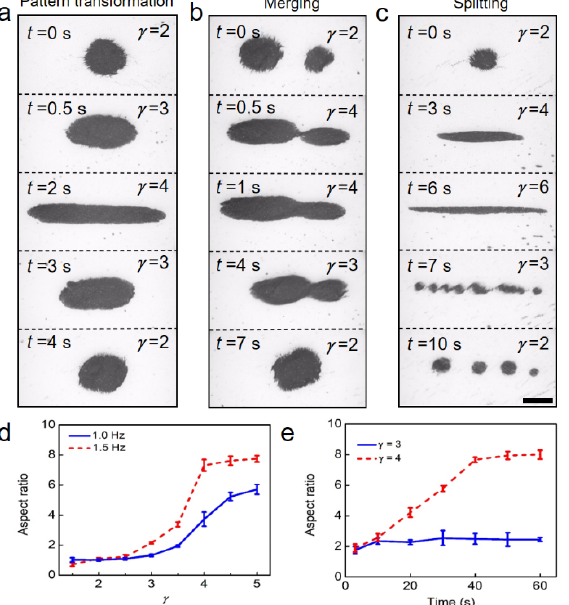
Figure 3. Controllable transformation of the swarm pattern. ( a ) Reversible transformations between disk, ellipse and ribbon patterns. ( b ) Merging process of two microswarms. ( c ) Controllable splitting of a magnetic microswarm. The scale bar is 400 μ m. ( d ) Variations of the aspect ratio, α , with the amplitude ratio, γ . ( e ) Time evolution of the aspect ratio of magnetic microswarms. The applied sawtooth field frequency, f , is 1.5 Hz. In ( d , e ), each data point represents the average of 3 experiments. The error bars indicate the standard